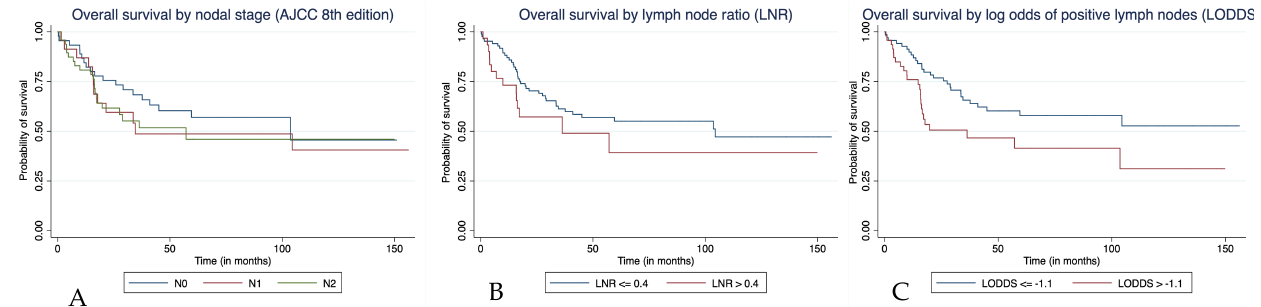
Figure 1. Kaplan – Meier curves showing overall survival of patients who underwent resection of primary small bowel adenocarcinoma with at least one lymph node sampled in the pathological specimen (n = 116) by ( A ) AJCC nodal stage ( B ) LNR, and ( C ) LOPLN. Table 3. Factors associated with overall survival in all patients (n = 116).